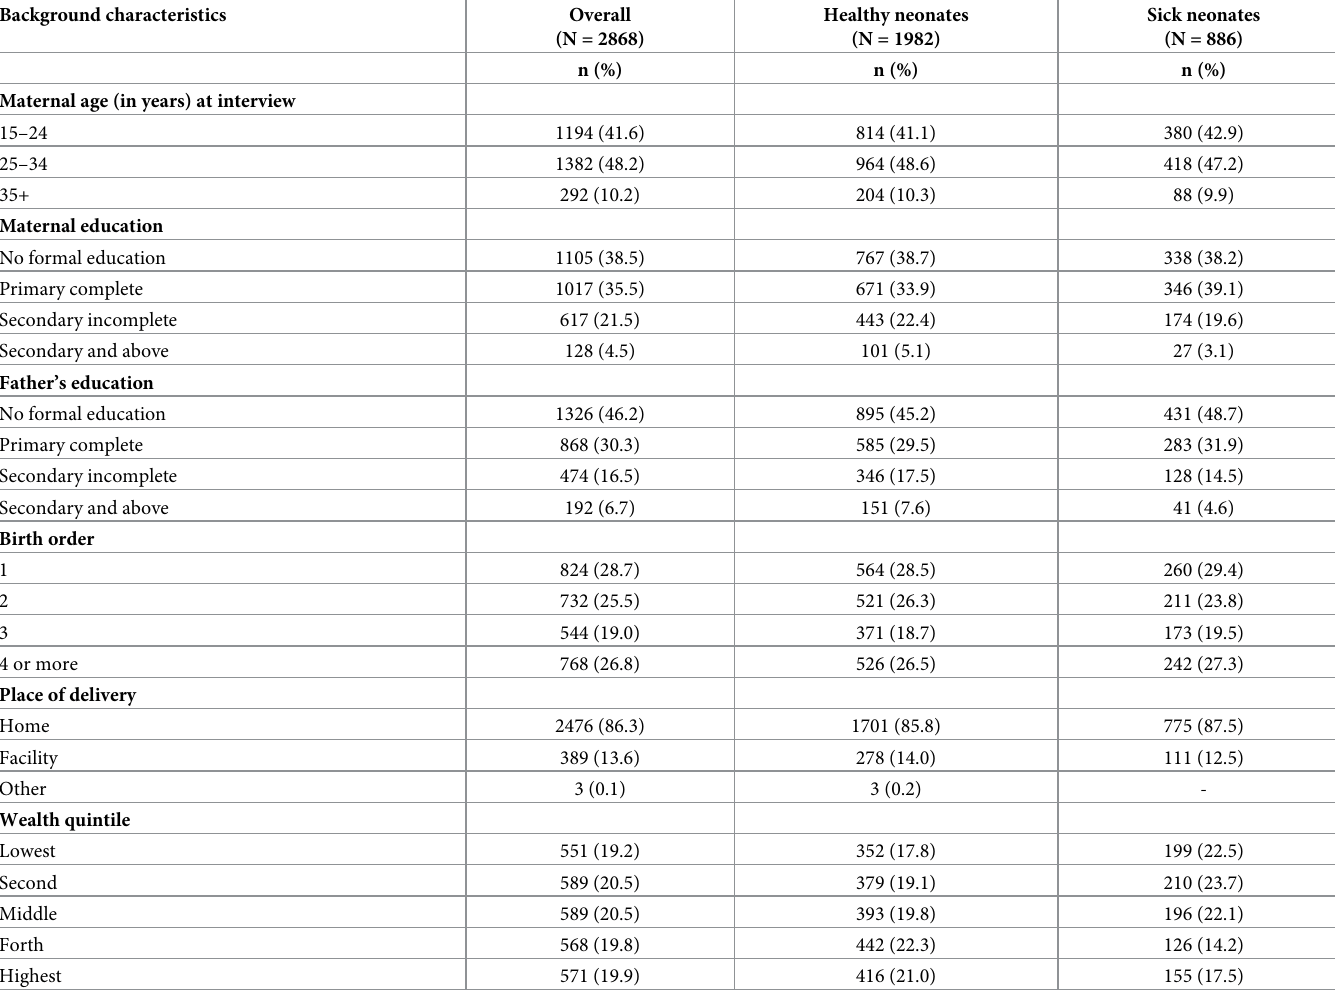
Table 1. Background characteristics of study participants, MNCS Endline Survey in